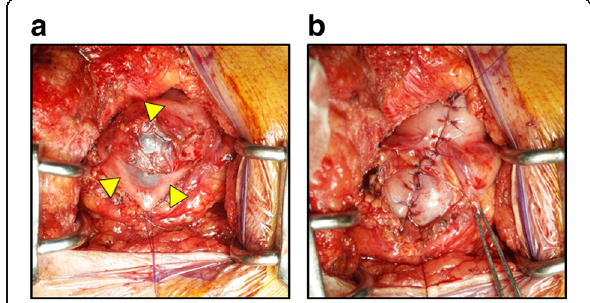
Fig. 4 Operative findings of the cystic tumor in the gastric antrum. Laparotomy showed the cystic tumor at the anterior wall of the stomach ( a ). Partial gastrectomy was performed, and the defect of the stomach was closed ( b )